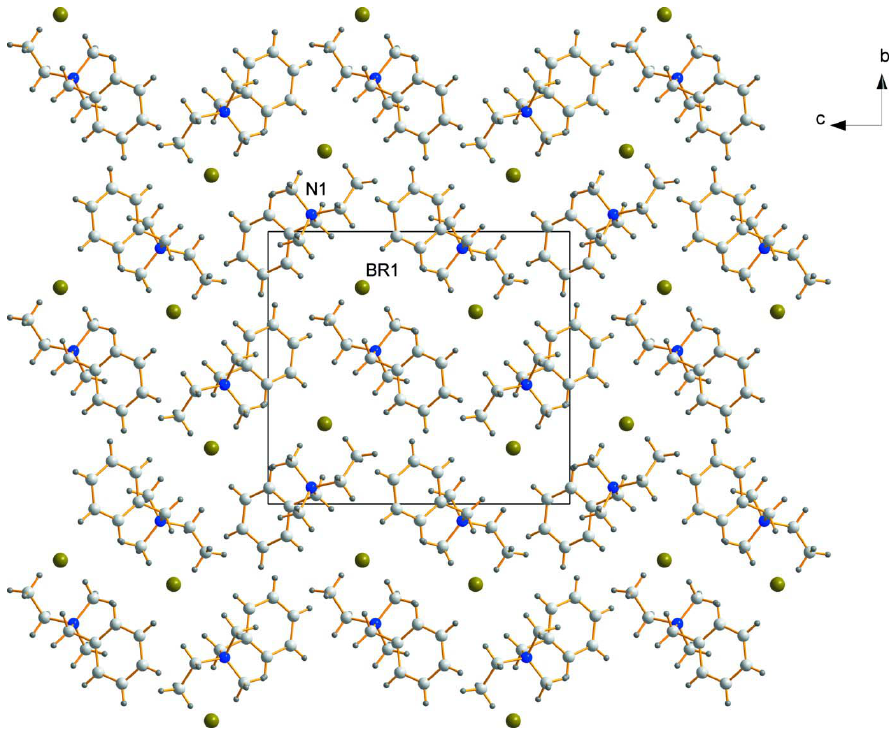
The sequence of the cationic and anionic layers along [010] in projecton onto (100) ( DIAMOND ; Brandenburg,